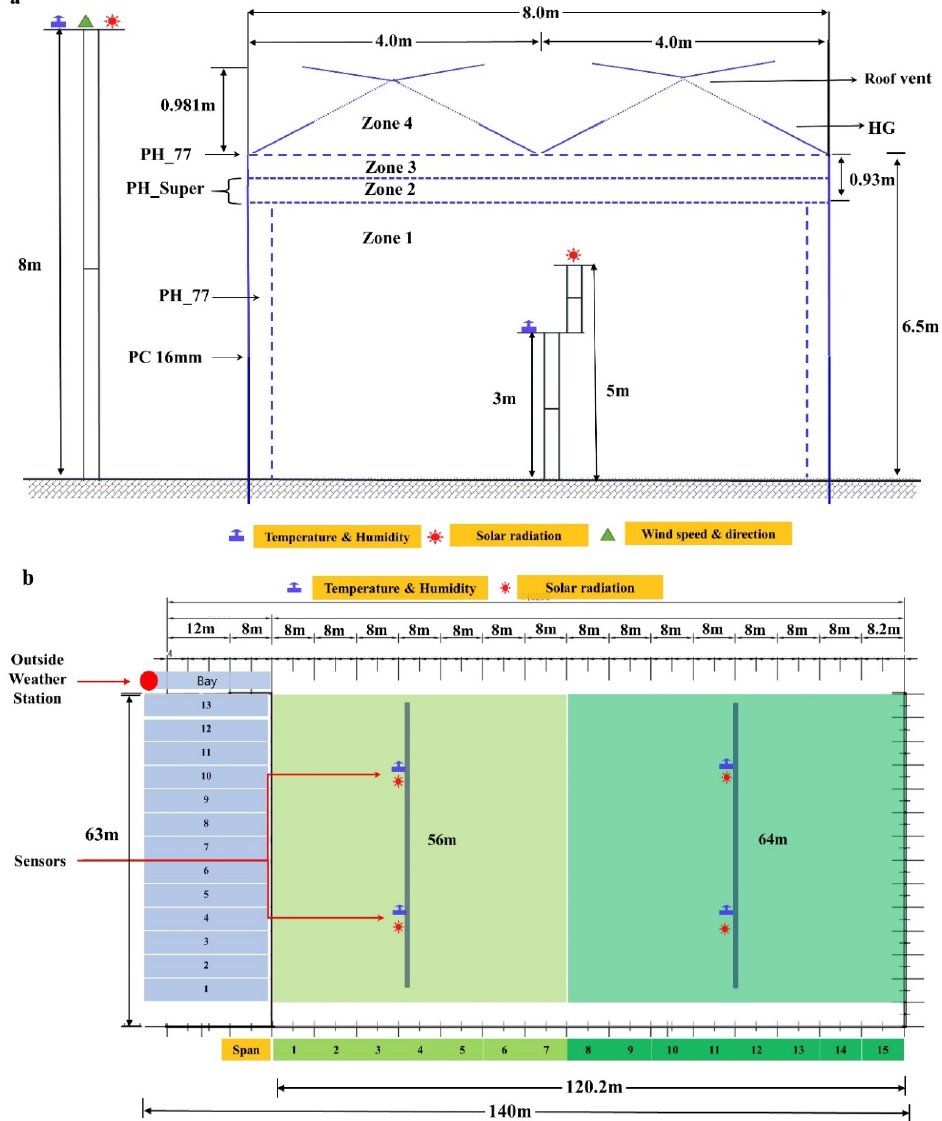
Figure 3. Greenhouse dimensions and positions of sensors in the experimental greenhouse: ( a ) vertical view and ( b ) horizontal view. (PC) Polycarbonate, (HG) Horticulture Glass, (Ph_77) Shading screen 1, (Ph_Super) Thermal screen 2 Table 1. Weather data variables used in the simulations.